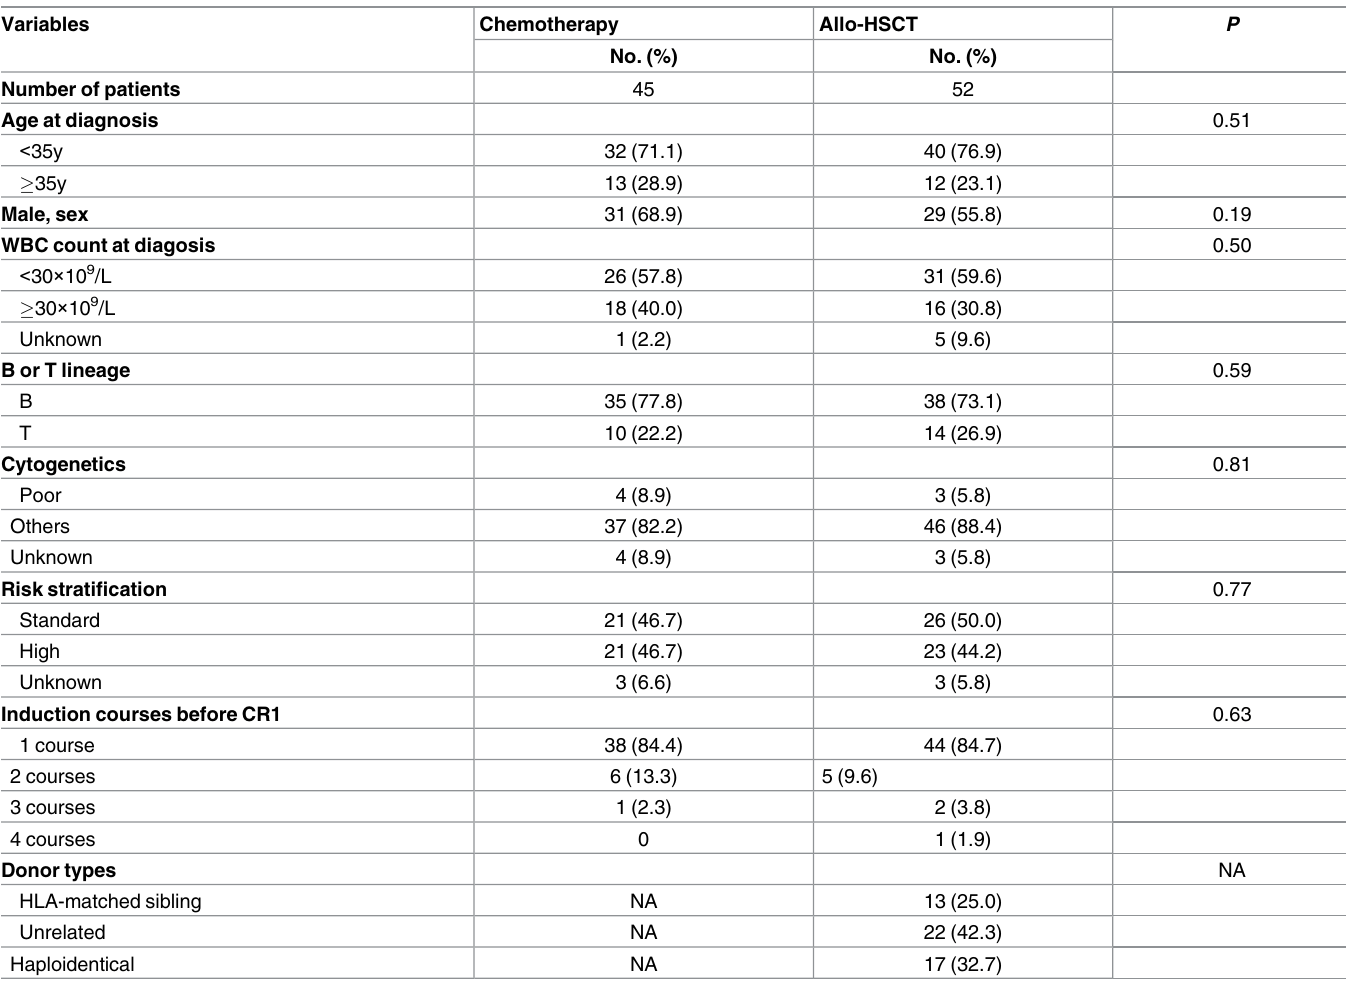
Table 1. Patient